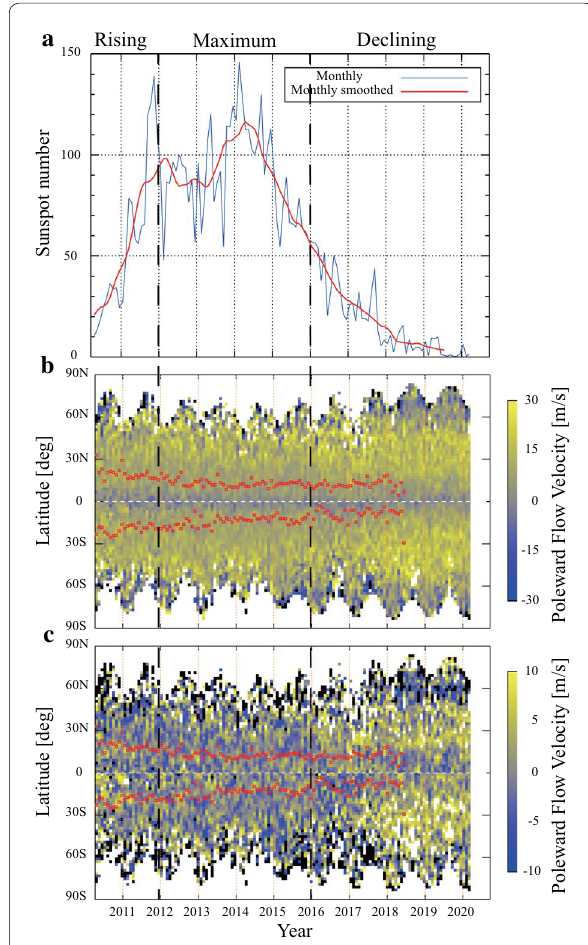
Fig. 3 Solar cycle-related variation of the poleward meridional flow during solar cycle 24 obtained using magnetic element feature tracking technique: a temporal variation of the sunspot numbers (data are from the Royal Observatory of Belgium), b temporal variation of the meridional flow, and c differences in the meridional flow from the average are